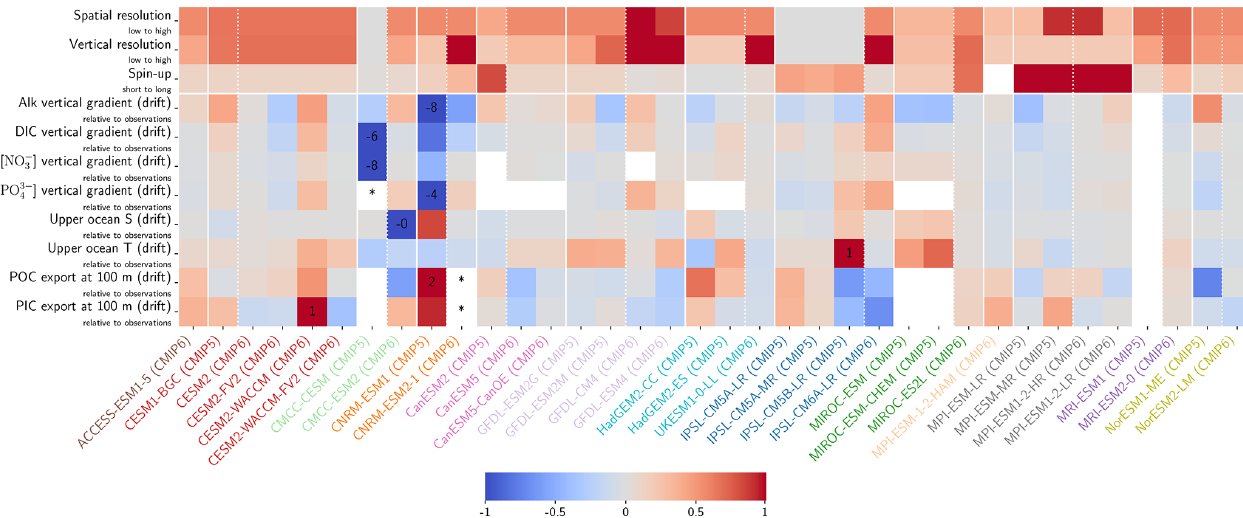
Figure 10. Resolution, spin-up and evaluation of drift in CMIP5 and CMIP6. ESM resolution and spin-up are normalized between 0 and 1, so that the highest model resolution and longest respective spin-up correspond to 1 (the maximum value attributed for the spin-up duration was set to 8000 years to keep the differences between MPI models and other ESMs visible). Model drift is normalized between − 1 and 1 so that the model with the maximum absolute drift corresponds to either 1 or − 1, and better-performing models have lighter cell colours. For each row, the highest model drift per century is expressed as a percentage of the observational estimate (e.g. CESM2-WACCM drift in PIC export at 100m represents 1% per century of observational estimates). Vertical gradients are assessed with the difference between the mean between 4000 and 5000m and the mean between the surface and 100m, while “upper ocean” refers to the mean between the surface and 100m. ESMs with an issue are marked with an asterisk, and when information is missing, the cell is left blank. POC and PIC export drifts at 100m are for the global ocean and not the open ocean, as is the case for other variables. CNRM-ESM2-1 (CMIP6) export data were not included due to extreme values in the Japan Sea, which affect the colour-scale normalization and might partly explain the model’s high PIC export at 100m (Fig. 6). Additional information on model resolution, spin-up and drift is available in Fig. C1 and Supplement Table